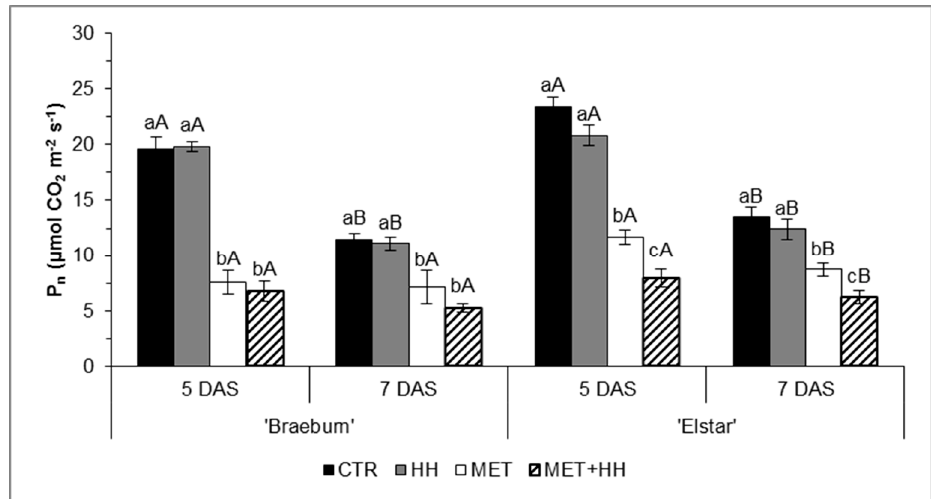
Figure 3. Leaf net photosynthesis (P n ) ( µ mol CO 2 m − 2 s − 1 ) evaluated 5 and 7 days after spraying (DAS), in the trials with ‘Braeburn’ and ‘Elstar’ apples in Sint-Truiden, Belgium. For each parameter, the mean values ± SE ( n = 8) followed by di ff erent letters express significant di ff erences between treatments within each day (a, b, and c), or between days within each treatment (A, B), using Tukey’s HSD test ( α -value ≤ 0.05). Treatments were control (CTR), increased relative humidity for 3 h prior spraying (HH), metamitron application at 247.5 mg / L (MET), and their combination (MET + HH).